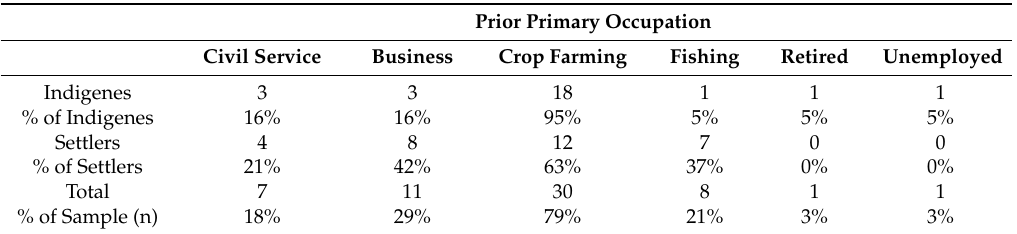
Table 3. Occupations of the affected persons prior to the resettlement (number of indigenes = 19; number of settlers = 19; n =